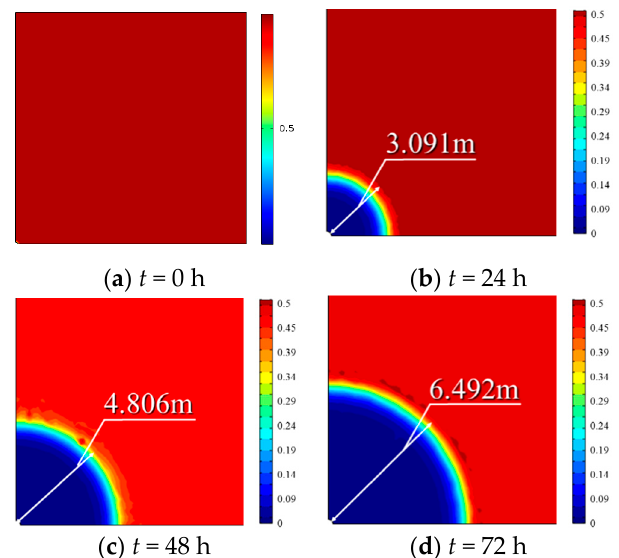
Figure 8. Spatial evolution of hydrate saturation of strata at different times. ( a ) Hydrate saturation in the reservoir at t = 0 h; ( b ) Hydrate saturation in the reservoir at t = 24 h; ( c ) Hydrate saturation in the reservoir at t = 48 h; ( d ) Hydrate saturation in the reservoir at t = 72 h.